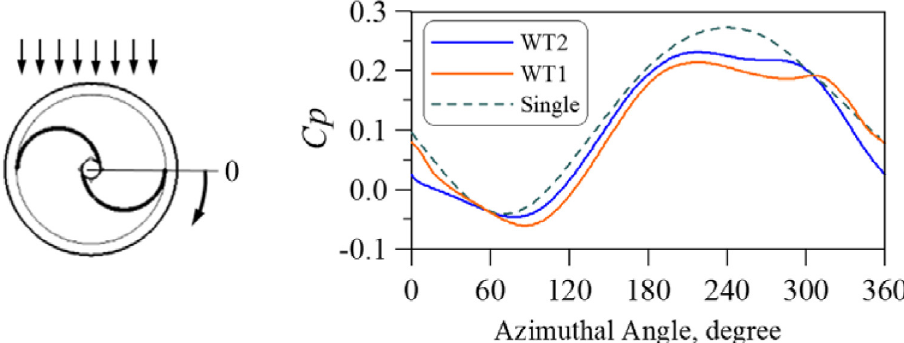
Fig. 6. Power coef fi cient with respect to azimuthal angle for l = 0.6.